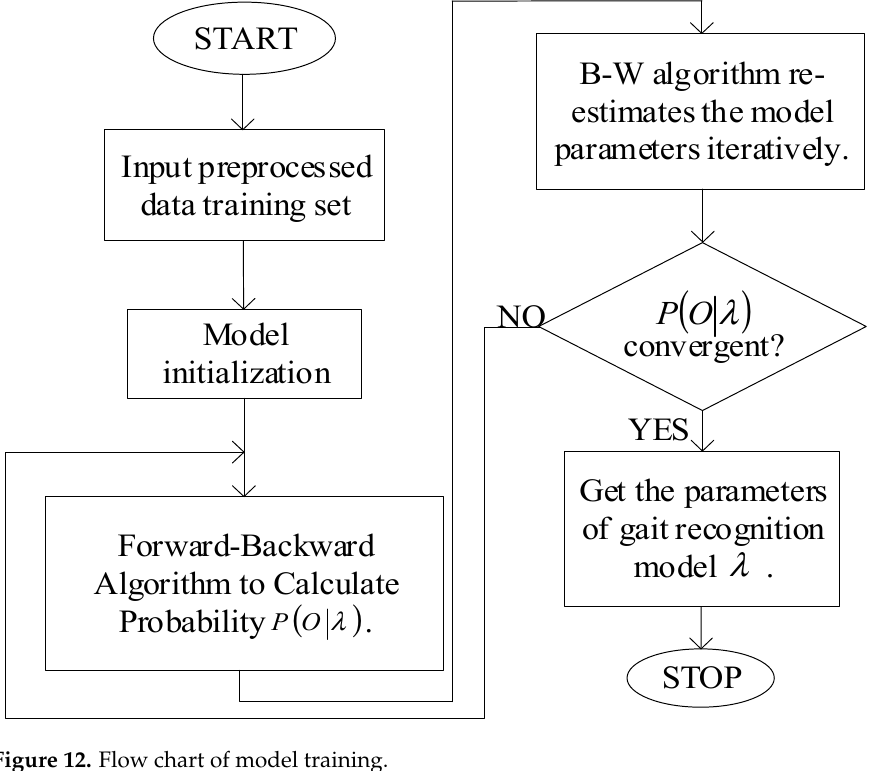
Figure 12. Flow chart of model training.